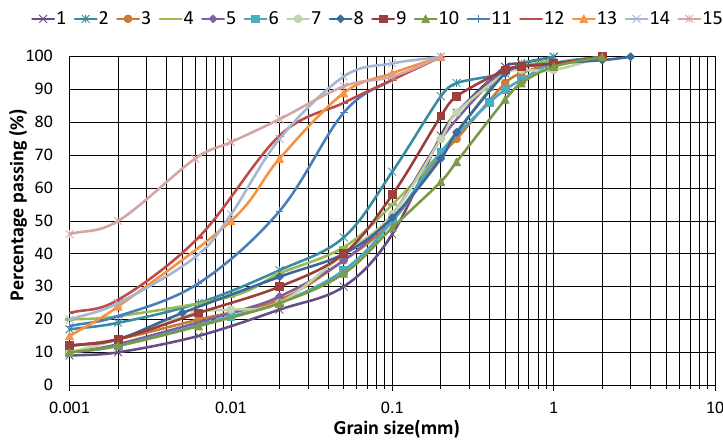
Figure 1. Grain size distribution curves of the test materials.